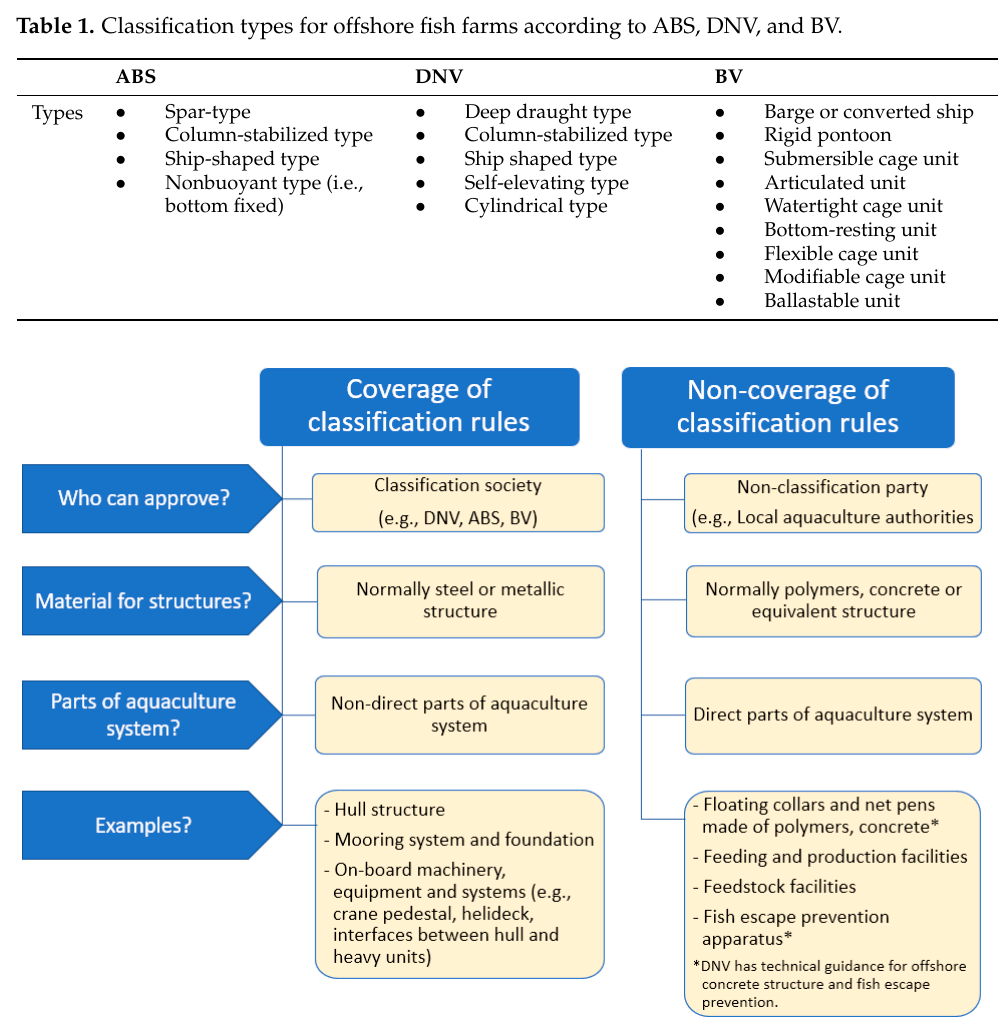
Figure 1. Diagram of coverage and noncoverage of classi fi cation rules for o ff shore fi sh farms.